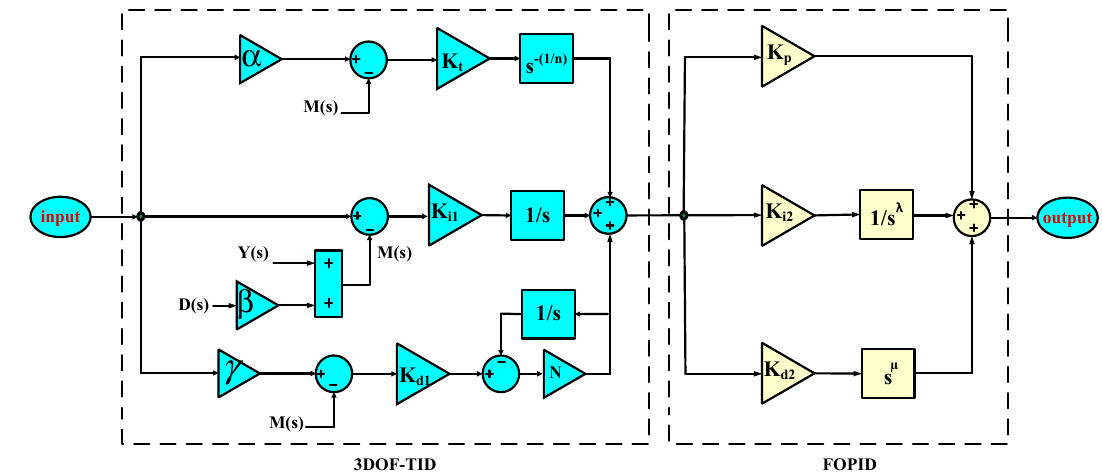
Figure 7. Block diagram of the 3DOF - TID&FOPID cascade controller.